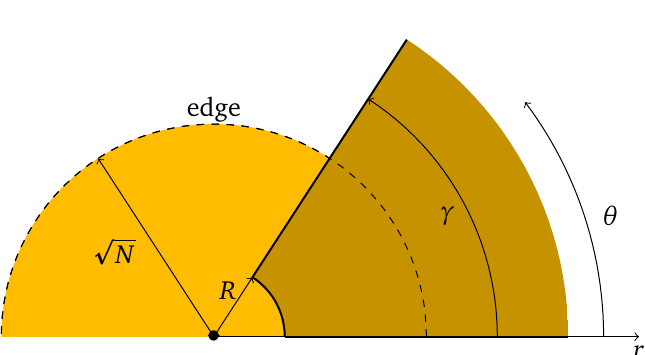
Figure 12: The 4D Hall droplet (yellow) and the spherical cap (27) (brown) projected on the ( r , θ ) plane. In terms of the full 4D system, each point having θ (cid:54)∈ { 0, π } is a torus spanned by ( α , β ) ; when θ ∈ { 0, π } , only a circle with coordinate ϕ ∝ α + β survives (and the origin r = 0 is just one point). The droplet is a ball with (dimen- (cid:112) N , and the spherical cap covers radii r ∈ [ R , + ∞ ) and azimuths sionless) radius θ ∈ [ 0, γ ]